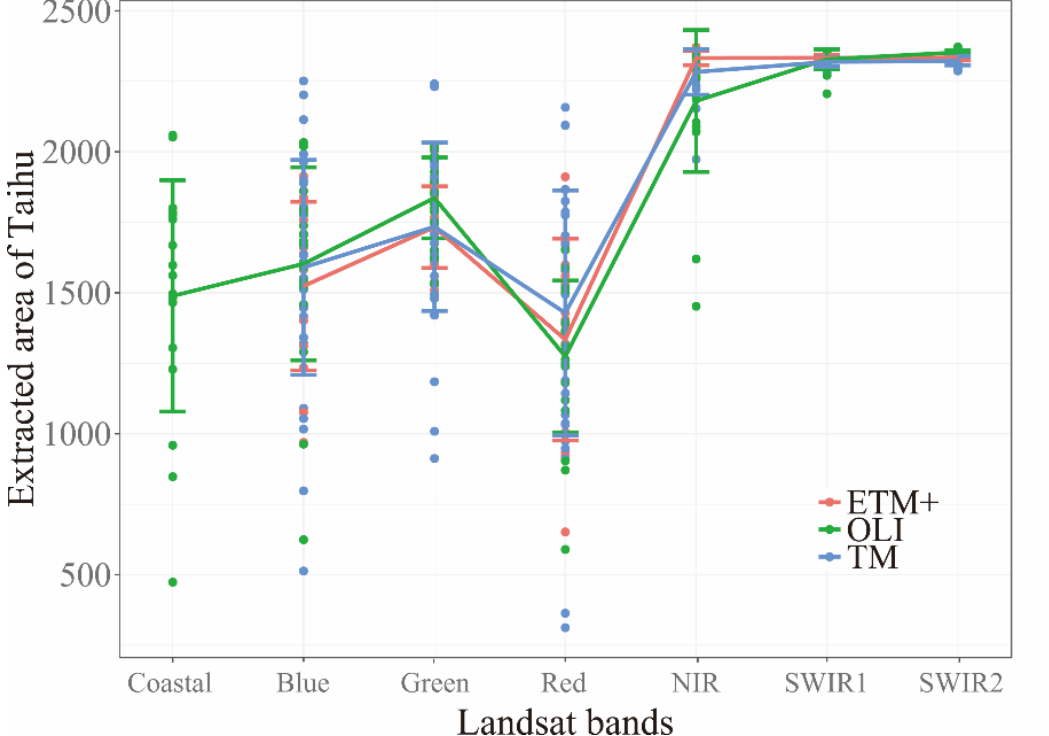
Figure 3. The area of extracted Taihu Lake across Landsat bands. TM = Thematic Mapper; ETM + = Enhanced Thematic Mapper; OLI = Operational Land